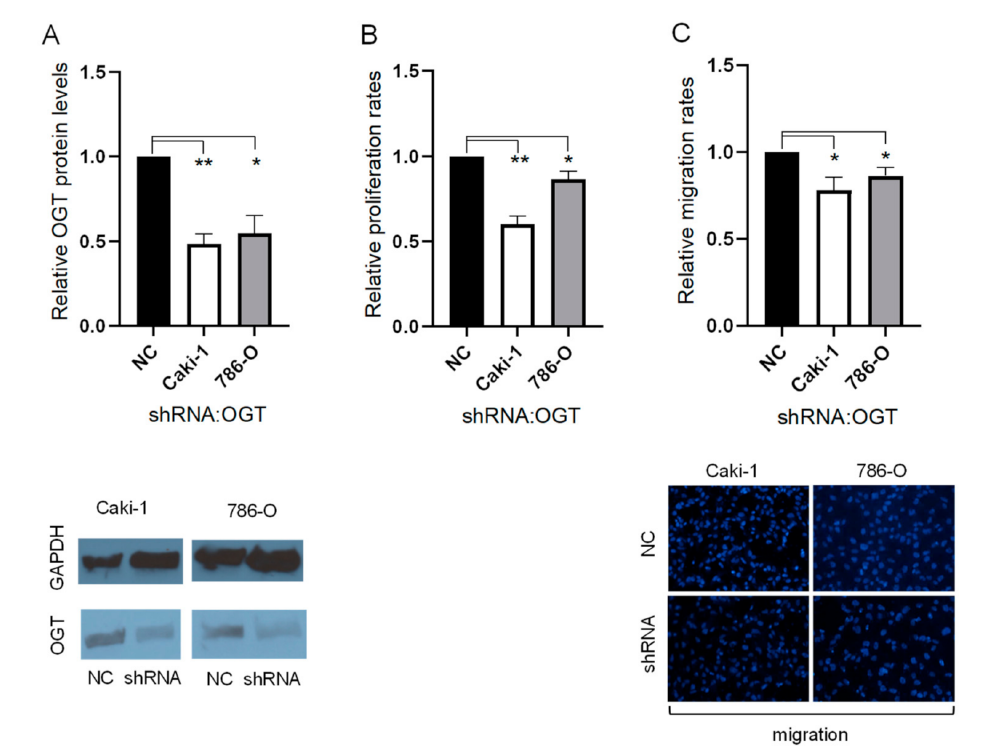
Figure 3. The effects of OGT knockdown on the ccRCC phenotype. ( A ) The OGT protein expression of cell lines treated with OGT shRNA, relative to negative control treatment (representative images below). ( B ) The proliferation rates of cell lines treated with OGT shRNA, relative to negative control treatment. ( C ) The migration rates of cell lines treated with OGT shRNA, relative to negative control treatment (representative images below, 20 × magnification) (Figures S11–S12). * p < 0.05 and ** p <